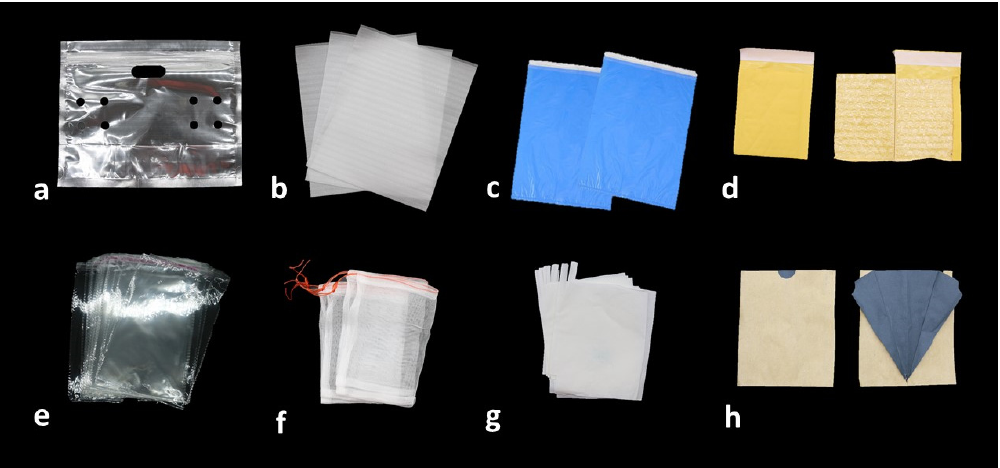
Figure 1. Different types of bagging materials used to improve the quality of fruits: ( a ) transparent paraffin bag; ( b ) nylon bags; ( c ) blue colored plastic bags; ( d ) two-layered bag (yellow paper outside and plastic inside); ( e ) cellophane bags; ( f ) organza bags; ( g ) paper bags; ( h ) two-layered paper bag (brown outside and grey inside).